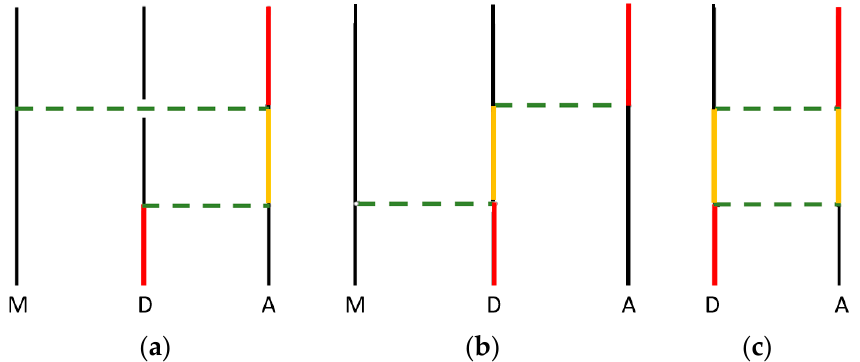
Figure 3. Representative near-zone graphs for calculating the matrix element for electronic energy transfer between a donor D and an acceptor A, modified by the electronic influence of a local electric dipole: ( a ) one of two time-orderings for the effect of a neighbouring third-body static dipole M on the acceptor A; ( b ) the other contribution, where M engages with the donor D; ( c ) the effect of static dipoles held by D and A. Colour coding as in Figure 2.